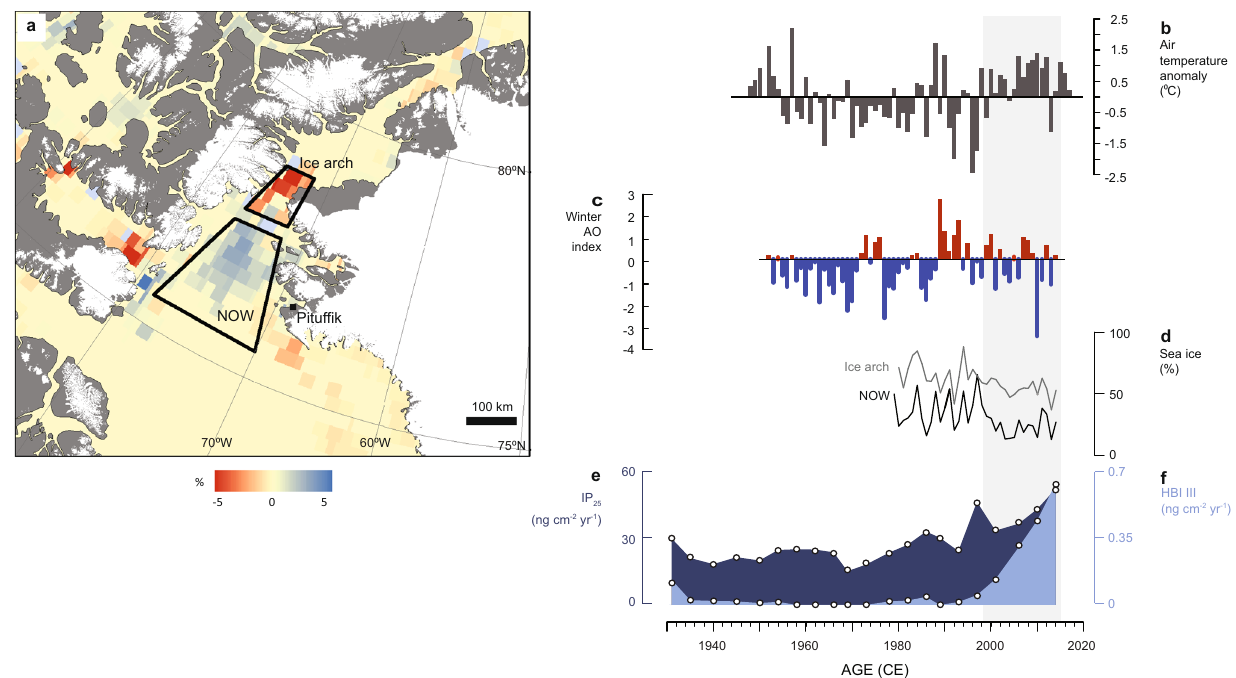
Fig. 7 Trends in atmospheric and sea ice conditions in the North Water region since the mid-twentieth century. a Anomaly map showing the difference in May – September sea ice concentration following the extreme AO + anomaly year of 1989 compared to the extreme AO-anomaly year of 1996 and location of the weather station at Pituf fi k (Thule Air Base). Extreme AO + conditions resulted in 5% sea-ice cover reduction in the ice arch area and an increase in drift ice in the polynya area compared to AO- conditions. b Air temperature anomaly for May – September at Pituf fi k. c Winter AO index. d . Average sea ice concentrations during May – September for the two regions of interest based on satellite observations (see Methods for details); e , f Fluxes of the sea ice biomarkers IP 25 and HBI III, respectively, in the box-core marine sediment record. The grey bar denotes a regime shift in sea ice (declining %) and air temperatures (positive anomalies) after